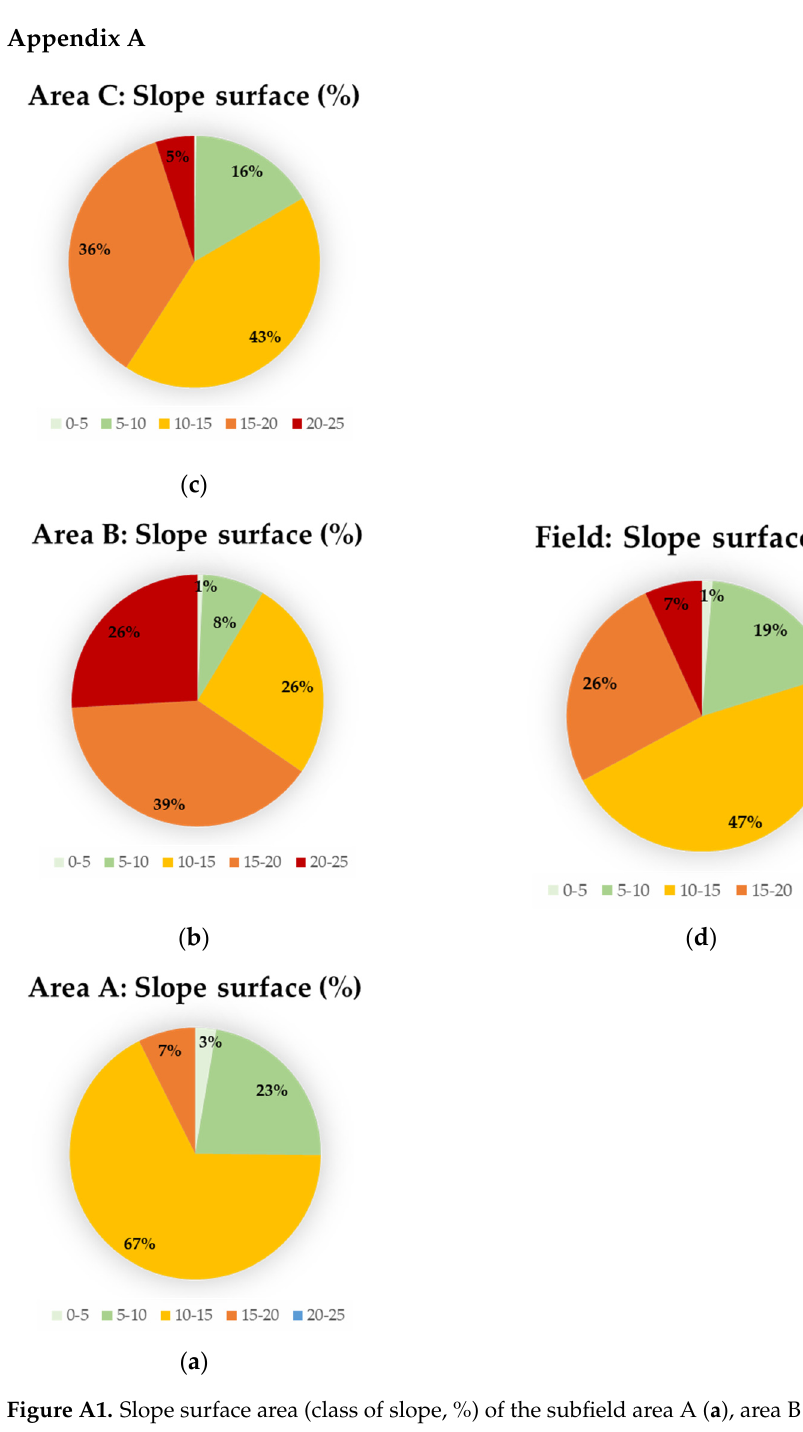
Figure A1. Slope surface area (class of slope, %) of the subfield area A ( a ), area B ( b ), area C ( c ), and of the experimental field ( d ).